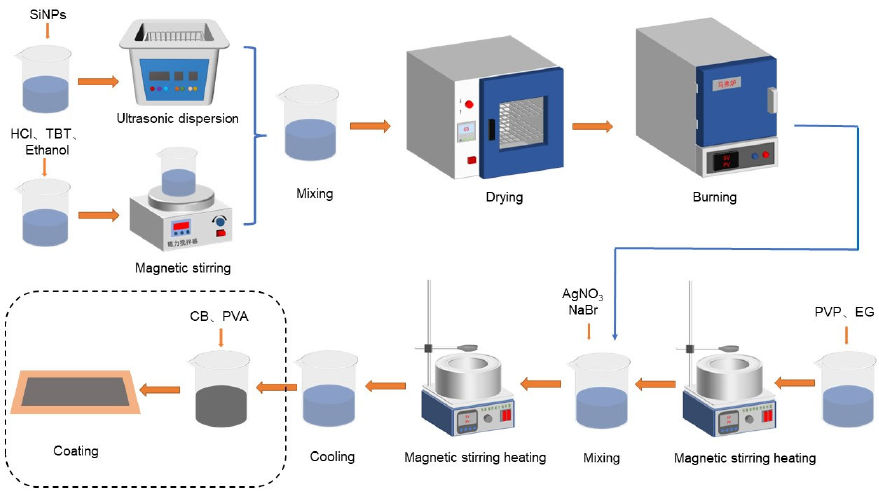
Figure 2. Schematic diagram of the preparation